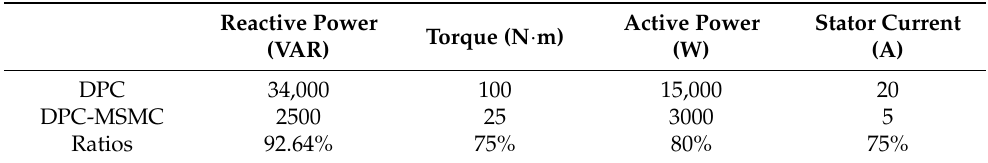
Table 4. Comparison of ripple values between the proposed and the classical DPC method (steps speed wind